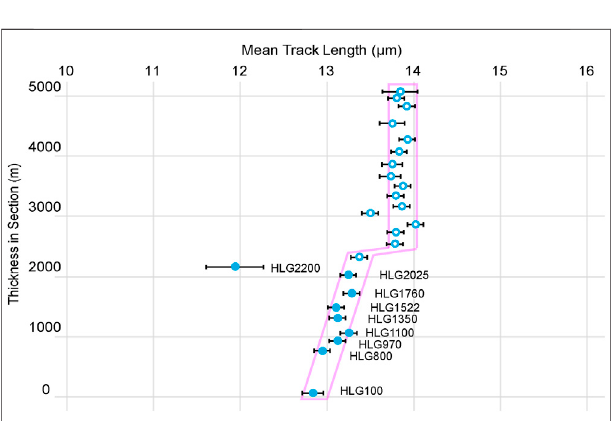
FIGURE 7 | Variation in mean track length with stratigraphic thickness in the HLG section. The mean track length (with ± 1SE) shown by the solid circle (this study) and hollow circle (He et al.,